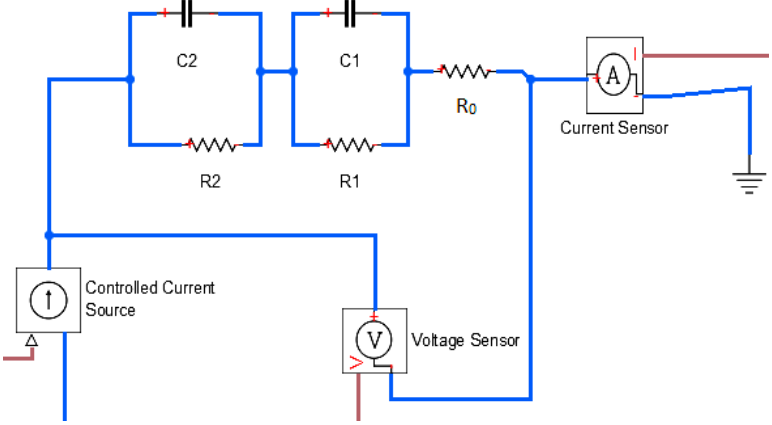
Figure 4. Equivalent diagram of the battery for the DP model in Matlab Simscape.